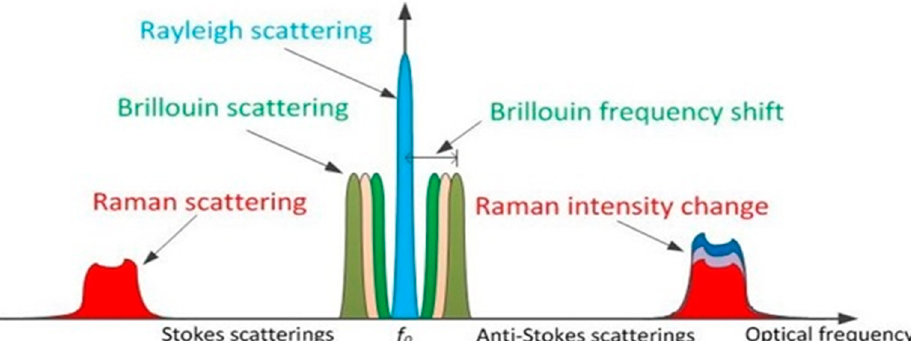
Figure 2. Backscattering processes used for distributed fibre sensing. f o is the frequency of the laser input. The Rayleigh scattering is due to a linear interaction of the light with the transmission medium, while all other components result from non-linear scattering processes.